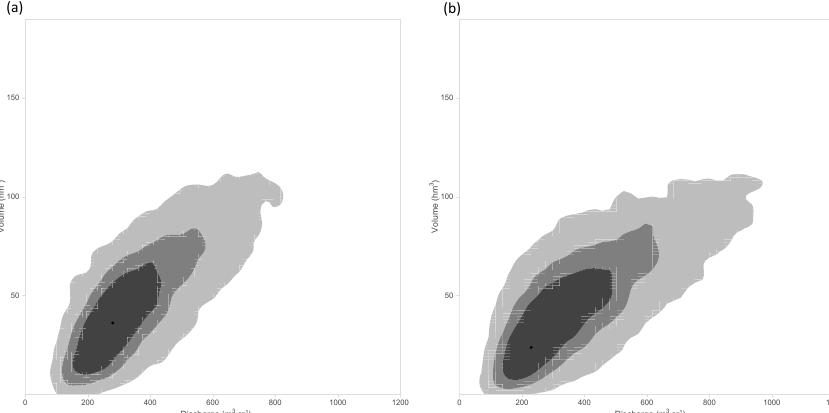
Figure 8. The 50th, 75th and 95th percentiles of the kernel density areas of MWLs with a return period of 50 years on the discharge–volume plane for single-site data (a) and multi-site data with historical information (b)